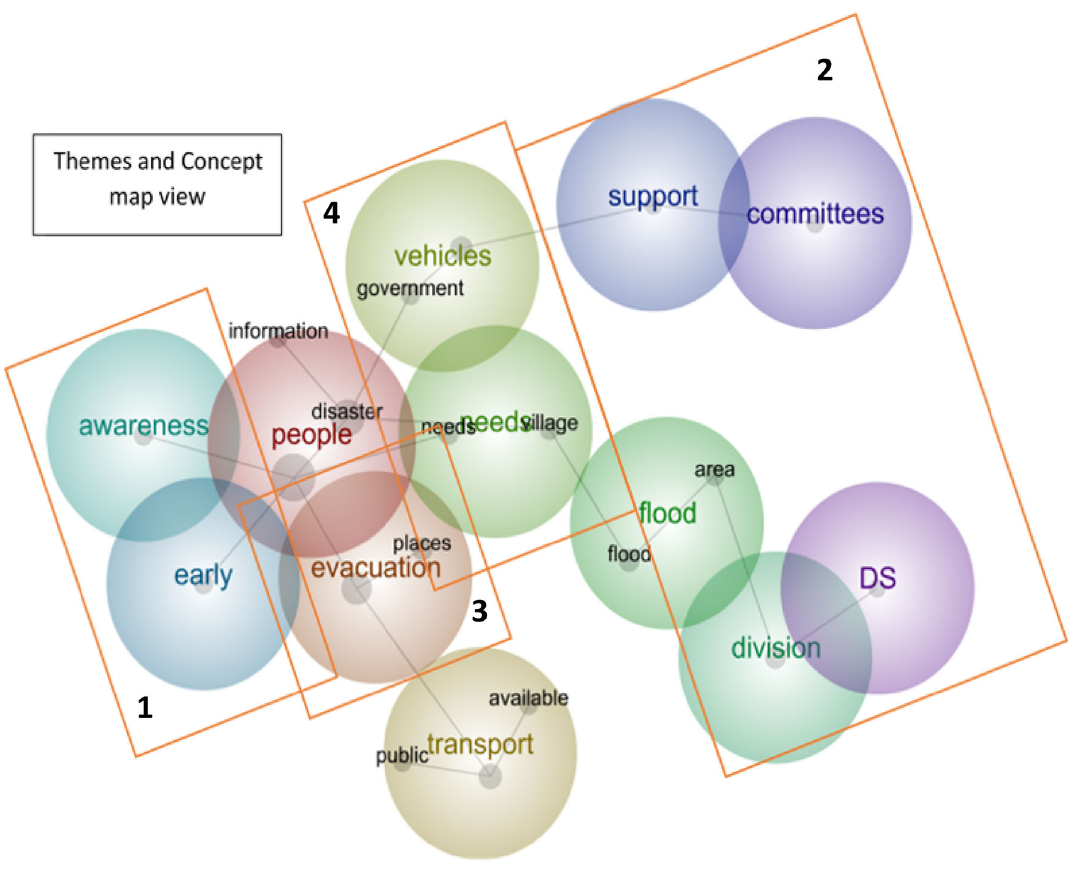
Fig. 5 Original Leximancer concept/theme map view from